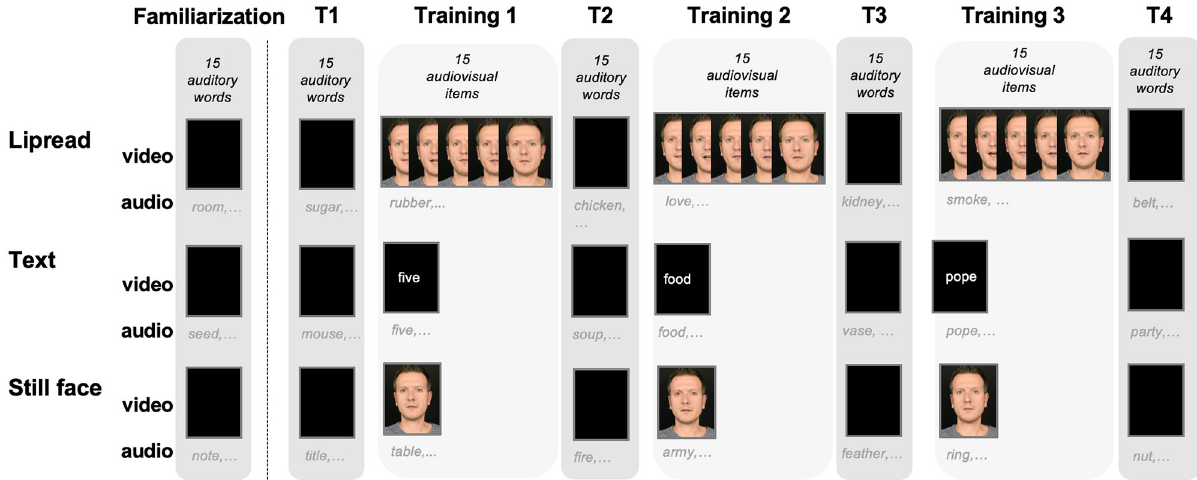
Fig 2. Experimental design. The familiarization phase and T1 consisted of 15 auditory words. Training blocks consisted of 15 audiovisual words or pseudowords, combined with either a dynamic face (i.e., lipread information), text, or a still face. Each training block was followed by an auditory-only test block (T2, T3 and T4) of 15 words. In total, there were three AV- training /Test blocks. After each training or test item, participants typed in what they had heard.